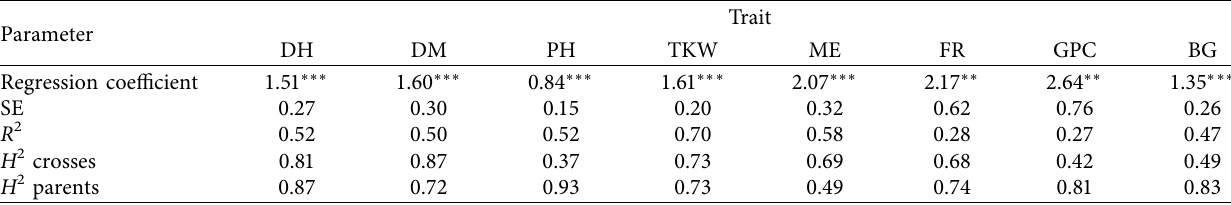
Table 9: Association of Mid-Parent Values (MPV) to Cross Means